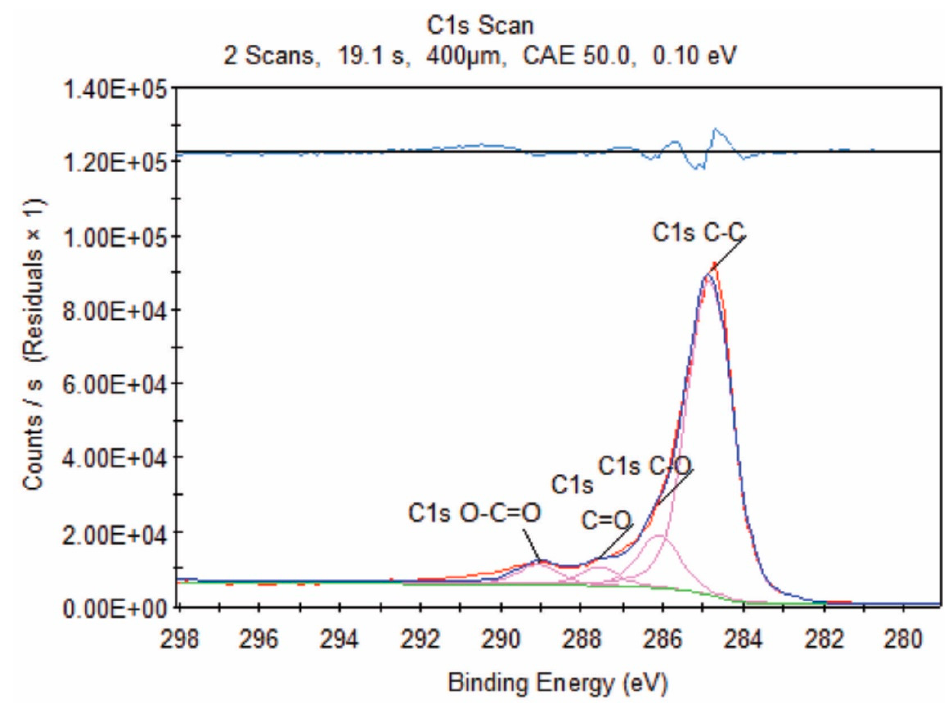
Figure 5. Peak deconvolution of C1s of the graphene modified with